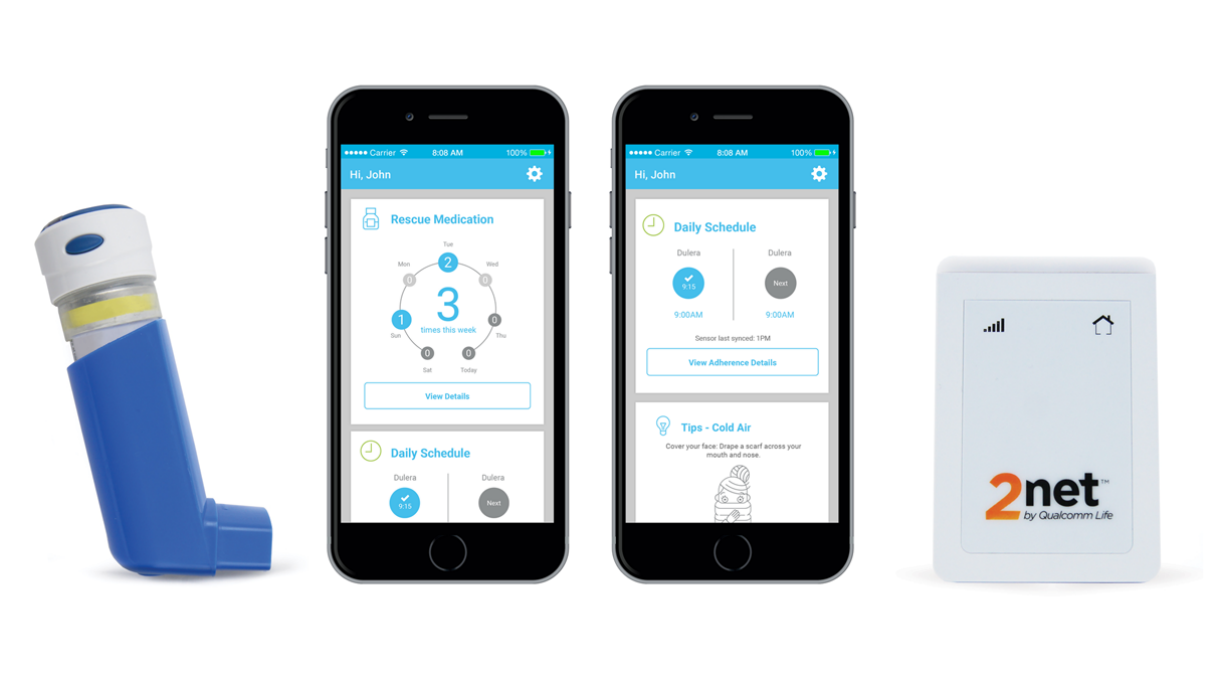
Figure 1. Propeller Health sensor device, smartphone app, and hub base station. The Propeller sensor attaches directly to the metered dose inhaler and objectively captures the date, time, and frequency of medication use. The sensor transmits these data wirelessly via Bluetooth to a paired smartphone, where a mobile app displays the information for the user. For participants without a smartphone, a wireless hub transmits the data, which are accessible through a Web-based